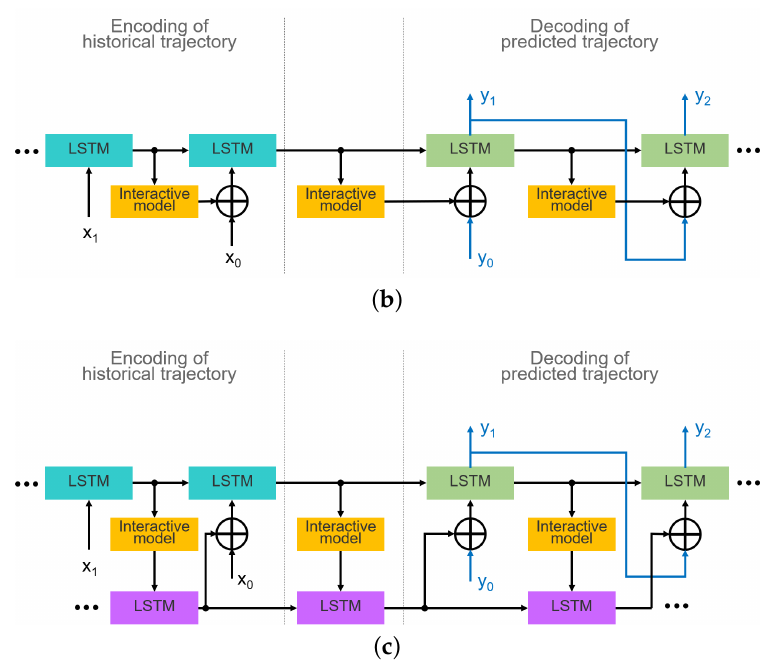
Figure 2. Three interaction model embedding methods in the LSTM encoder–decoder network. ( a ) Embedding interaction model only at the current frame. ( b ) Embedding interaction model at each frame. ( c ) Embedding interactive model with spatial–temporal